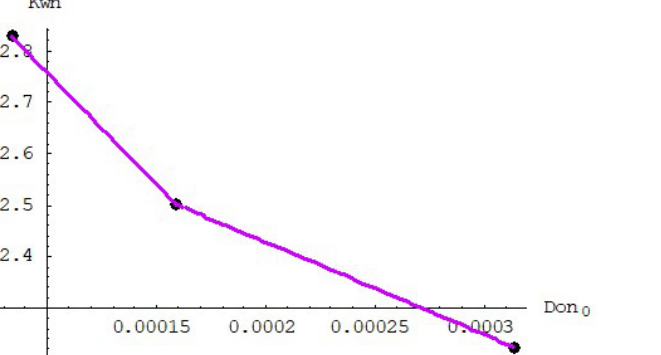
Figure 4. Dependence on the initial electron donor concentration of the average number M n and average weight M w molecular weights of polypropylene chains synthesized at the residence time in the reactor τ = 60 min.